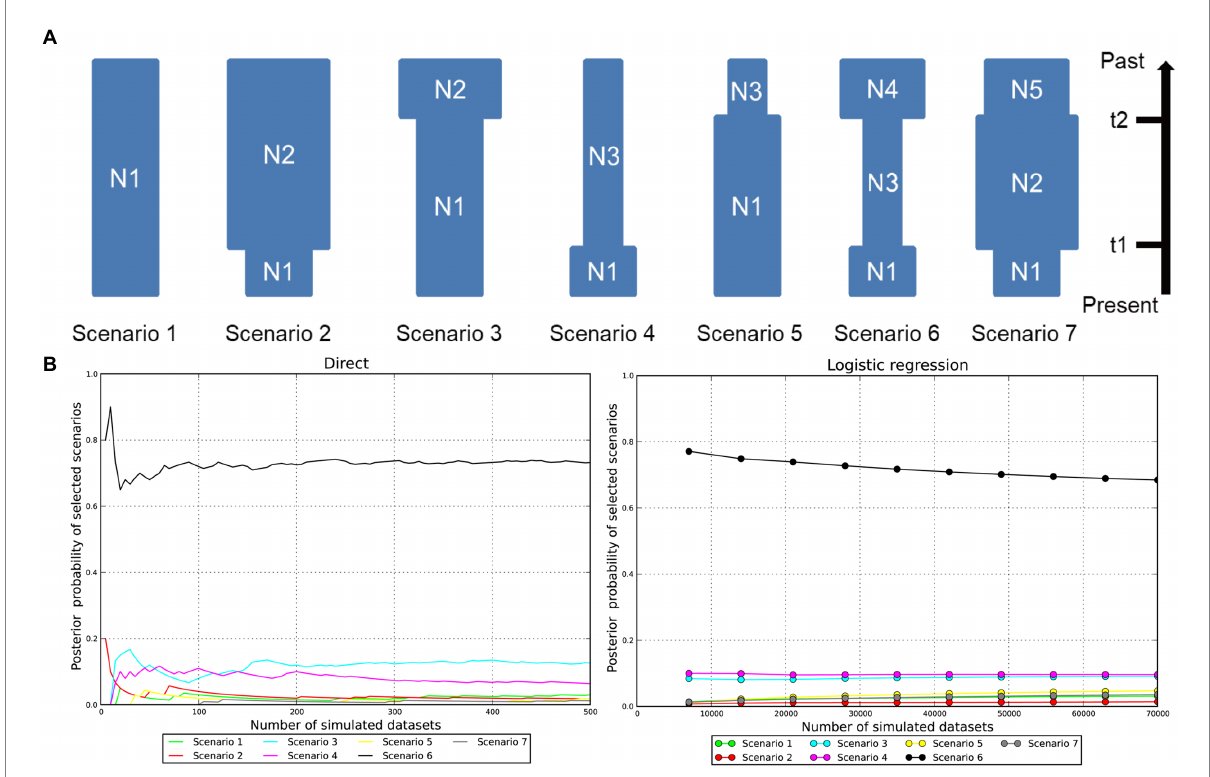
FIGURE 5 Inference of the plausible scenarios of demographic dynamics within Jankowski’s Bunting by DIYABC. (A) Seven possible scenarios previously defined without any prior information. Scenario 1: constant effective population size (N1); Scenario 2: a recent bottleneck (N2 to N1, t1); Scenario 3: an old bottleneck (N2 to N1, t2); Scenario 4: a recent expansion (N3 to N1, t1); Scenario 5: an old expansion (N3 to N1, t2); Scenario 6: an old bottleneck (N4 to N3, t2) followed by a recent expansion (N3 to N1, t1); Scenario 7: an old expansion (N5 to N2, t2) followed by a recent bottleneck (N2 to N1, t1). (B) The estimation of posterior probabilities under direct estimate and logistic regression for the seven tested